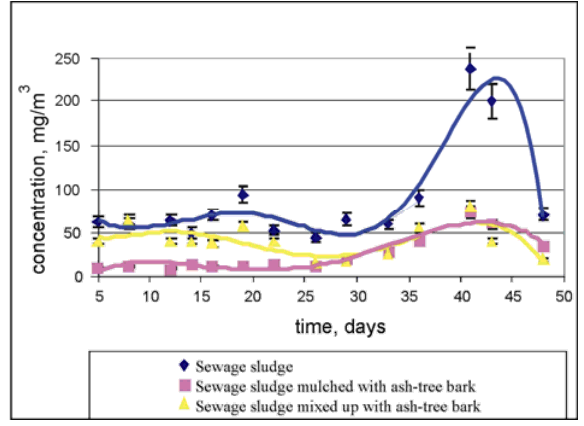
Fig. 4. Ammonia gas emissions during composting sewage sludge with ash-tree